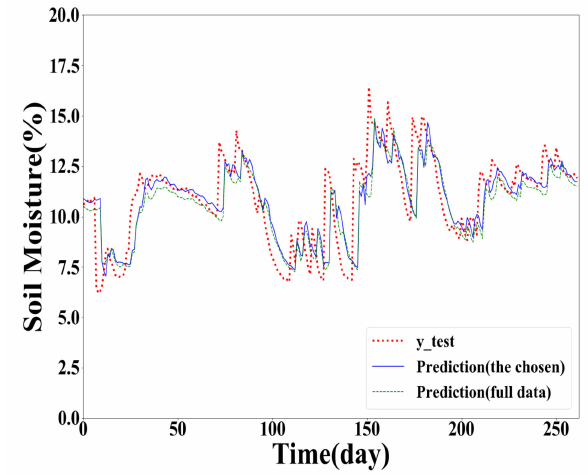
Figure 4. Points forecasting results in Y(3) prediction.